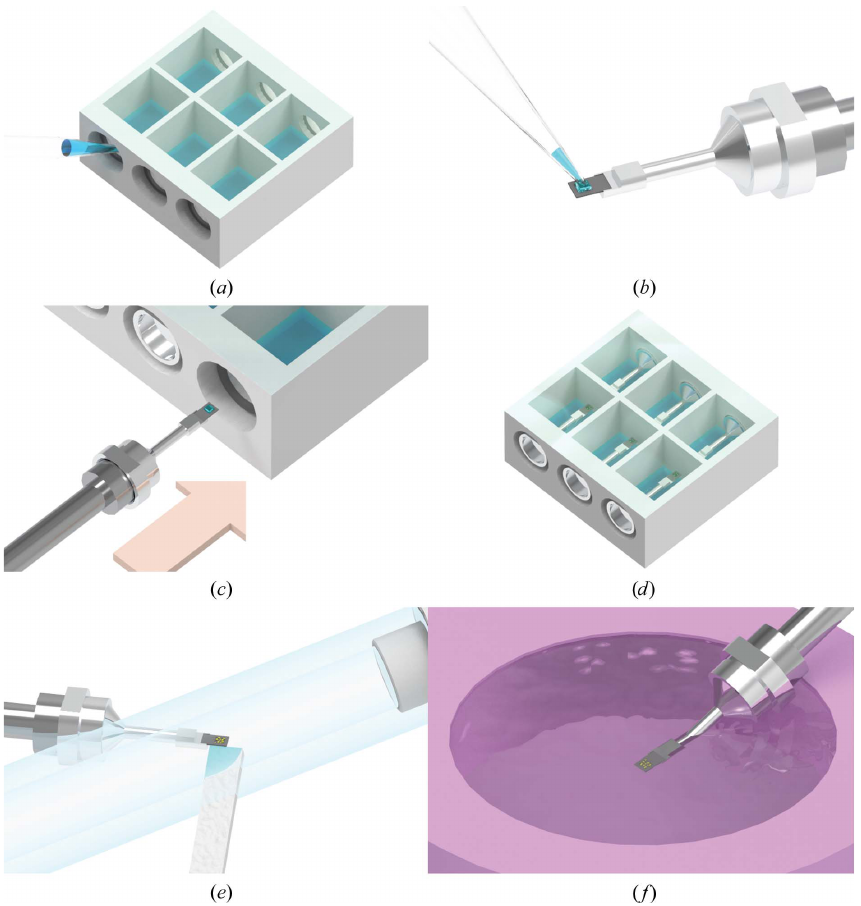
Figure 2 Procedure for on-chip crystallization on Roadrunner I chips. ( a ) For a crystallization experiment, the top of the chamber is sealed with transparent tape before the chamber wells are filled with (cid:7) 500 m l reservoir solution through the side opening. ( b ) The protein solution is mixed with precipitant solution and about 2–3 m l of this crystallization mixture is applied to the chip surface. ( c ) The chips are inserted into the crystallization chamber from the side and are held in place by a magnetic ring attached to the lateral opening of the chamber that interacts with the magnetic base of the chip. ( d ) Crystal-growth kinetics are monitored by light microscopy using top light illumination. ( e ) When crystal growth is complete, the chips are taken out of the chamber using a magnetic wand. The excess growth solution is removed through the membrane pores of the chip using a soft tissue, as described by Roedig et al. (2015, 2016). During all handling steps, starting from the removal of the mother liquor and until room-temperature measurements at the beamline are finished, it is essential to keep the crystals hydrated in a stream of humidified air (Sanchez- Weatherby et al. , 2009; Roedig et al. , 2016). The optimal level of applied humidity has to be tightly controlled and investigated beforehand for each protein individually, as this depends on the buffer composition (Wheeler et al. , 2012). For protein buffers that only contain low concentrations of salt and/or PEG, 98–100% humidity is usually suitable. ( f ) As an alternative to room-temperature measurements, crystals on a chip can be flash-cooled by plunging the chip into liquid nitrogen prior to cryogenic data collection (Roedig et al. ,